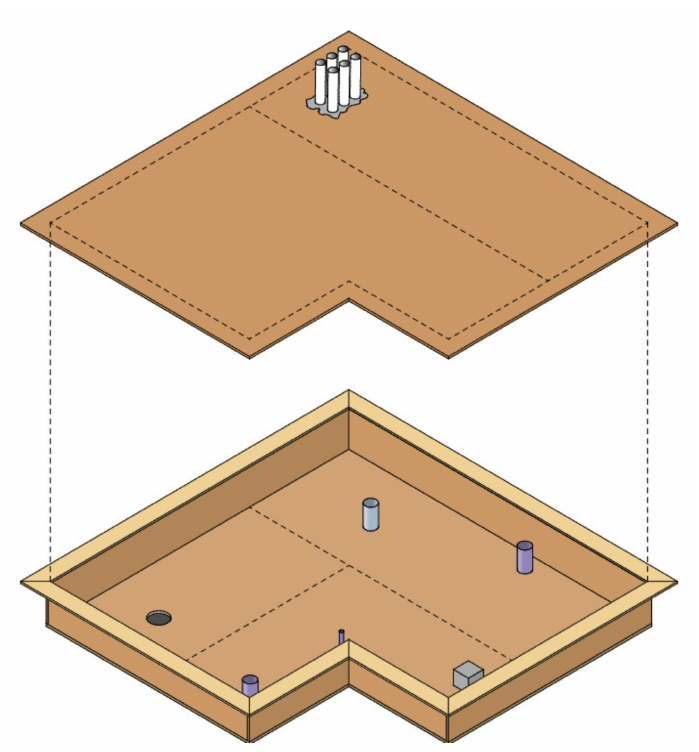
Figure 8. Sketch of mock-up measuring the barrier